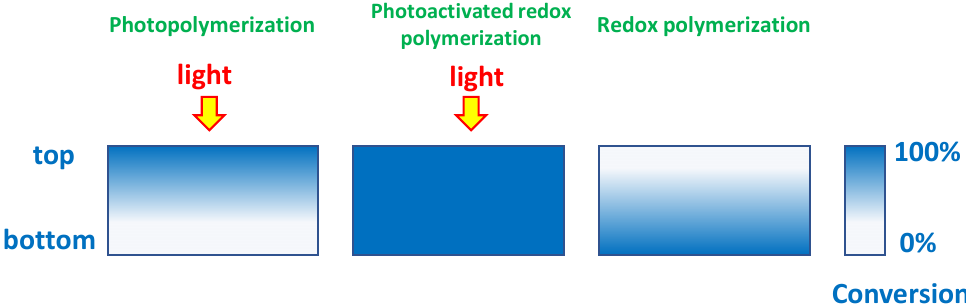
Figure 38. Polymerization profiles obtained during the FRP of the (1,4-BDMA / HPMA / UDMA) blend under air with the three-component systems Cu-42 / 2-dppba / Iod (1% / 1.8% / 1.9% w / w / w ) ( A ) with and without light at 405 nm ( B ) with and without light irradiation at 785 nm. ( C ) Color of the photocurable resin before polymerization, after irradiation at 405 nm or after polymerization at 780 nm. Reproduced with permission from the authors of [69]. Copyright 2017 John Wiley & Sons Ltd.